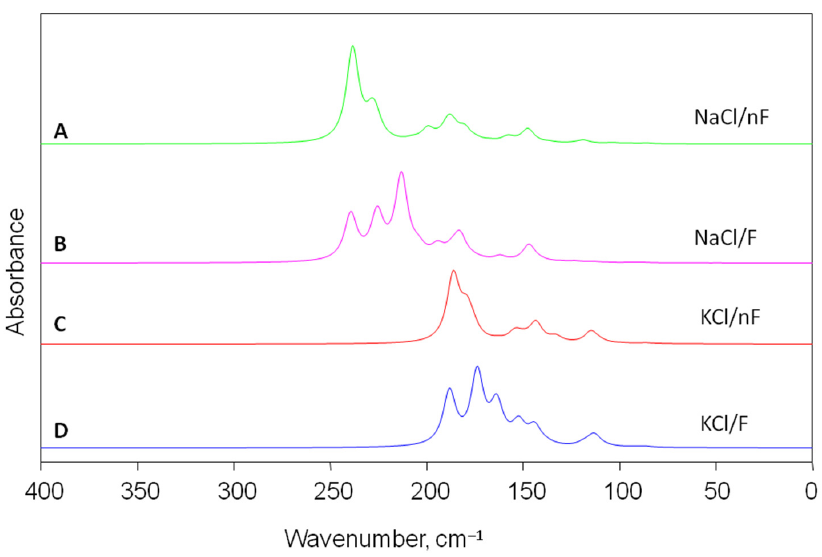
Figure 6. Computed infrared spectra for 125-atom NaCl and KCl models of crystal in the spectral range of 400–0 cm − 1 : A—NaCl/nF/B3LYP/6-31g*, B—NaCl/F/B3LYP/6-31g*, C—KCl/nF/B3LYP/6-31g*, D—KCl/F/B3LYP/6-31g*. (Half-bandwidths 4 cm − 1 , no scaling factor, nF—calculation of geometry without any restriction, F—calculation of geometry with “frozen” all angles).